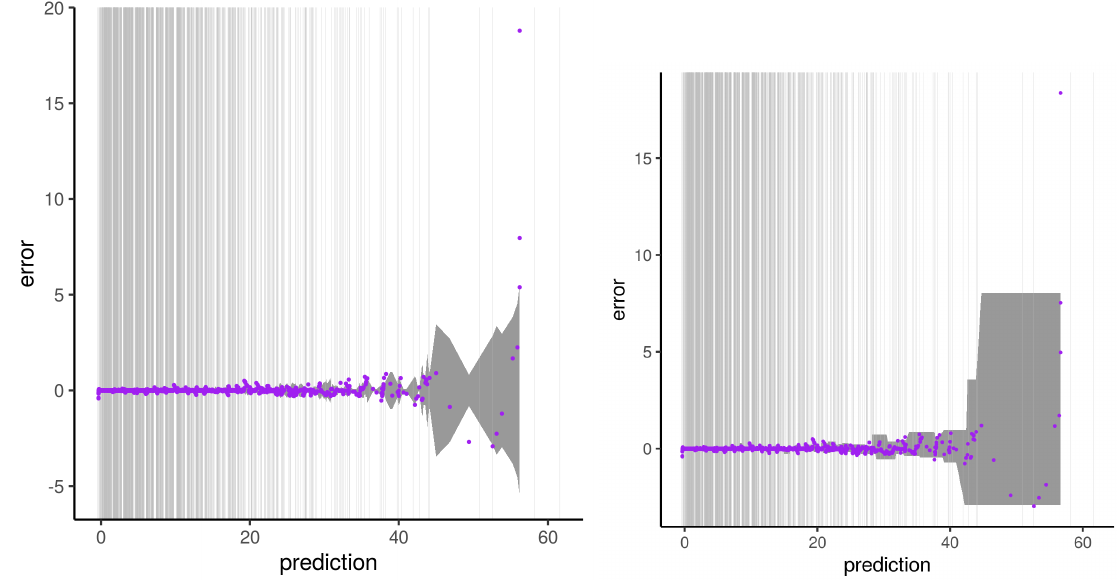
Figure 13. Same as Figure 12 for the second run of the